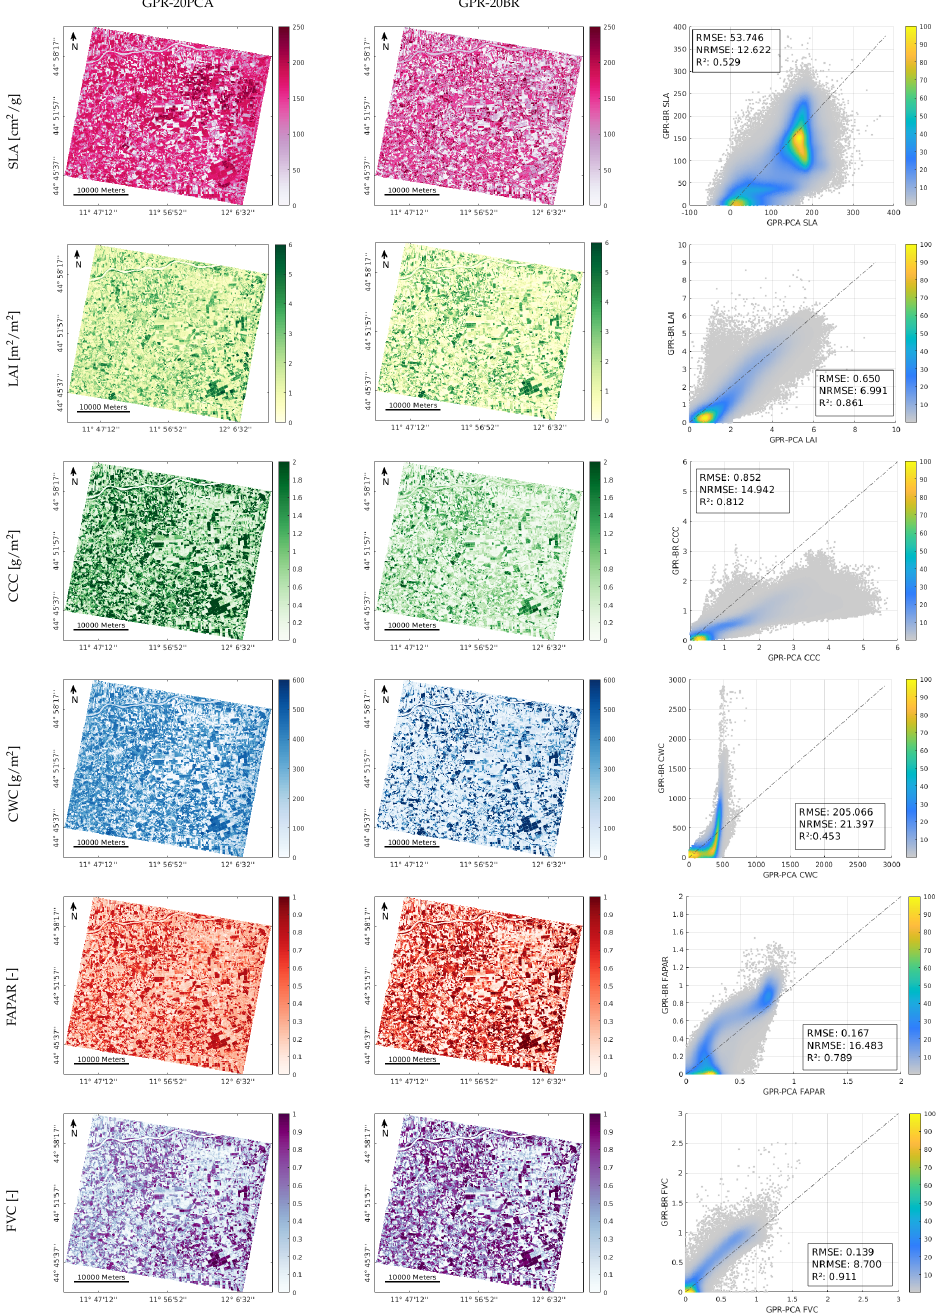
Figure 9. Mapping results of estimated variables SLA, LAI, CCC, CWC, FAPAR and FVC over Jolanda di Savoia site on 26 June 2020. The PRISMA scene was spectrally resampled to future CHIME configuration. Maps of the GPR-20PCA ( left ) GPR-20BR ( right ) generated models, and comparison of the two methodologies as scatter plots ( right